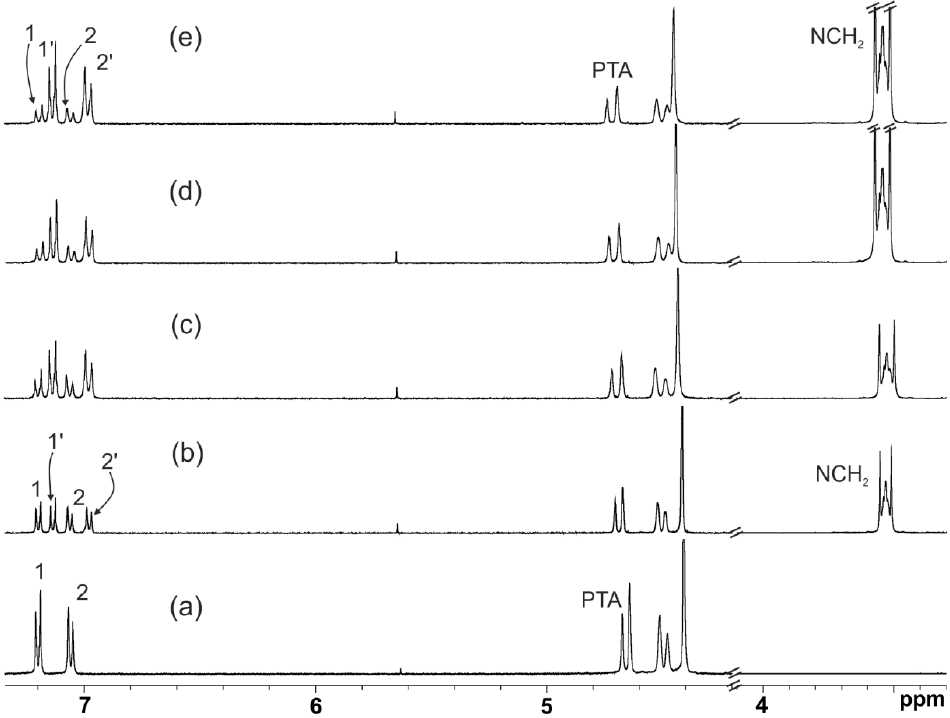
Figure 4. Selected regions of the 1 H NMR spectra (400 MHz, acetone-d 6 , 298 K) acquired during the titration of the model compound 6Au (5 mM) ( a ) with incremental amounts of TBACl: ( b ) 2 equiv. of TBACl just after addition; ( c ) 2 equiv. of TBACl after 1.30 h; ( d ) 4 equiv. of TBACl just after addition ( e ) 4 equiv. of TBACl after 10 h. See Scheme 2 for proton assignment. Primed protons correspond to protons of [ 7Au ] − anionic dimer.